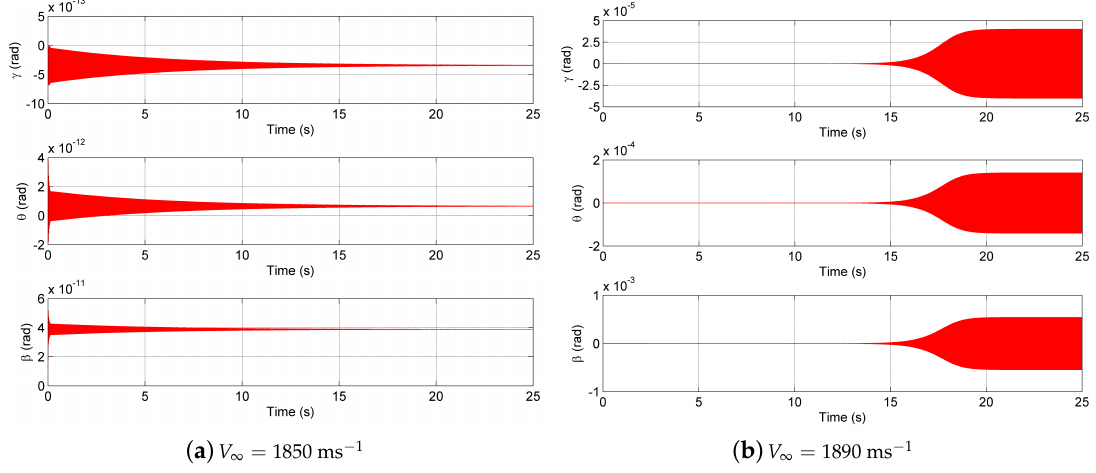
Figure 12. Dynamic response of the hot